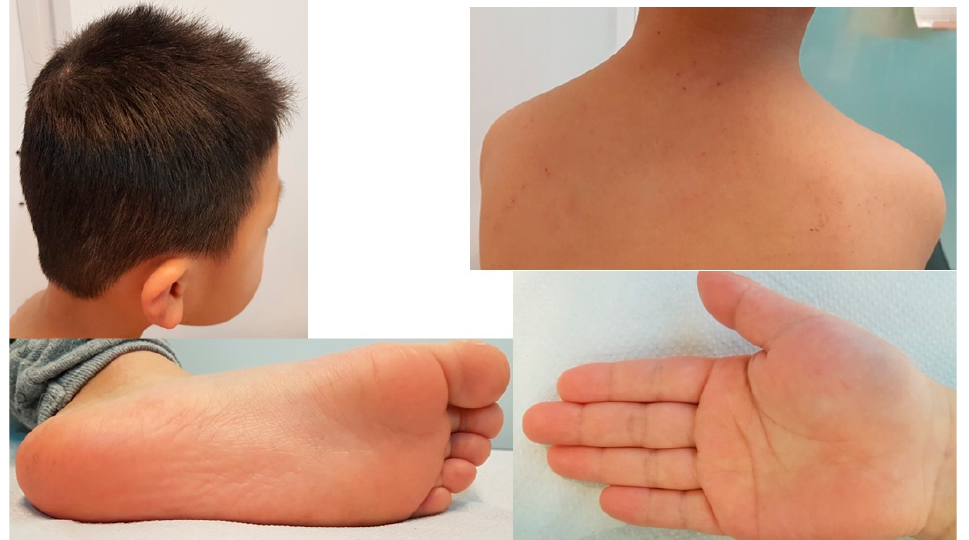
Figure 4. Erythema and some fissures on the soles of the feet suggestive of atopic pulpitis. Table 1. Comprehensive phenotypic description of the patient based on the WNT10A gene using Human Phenotype Ontology (HPO).